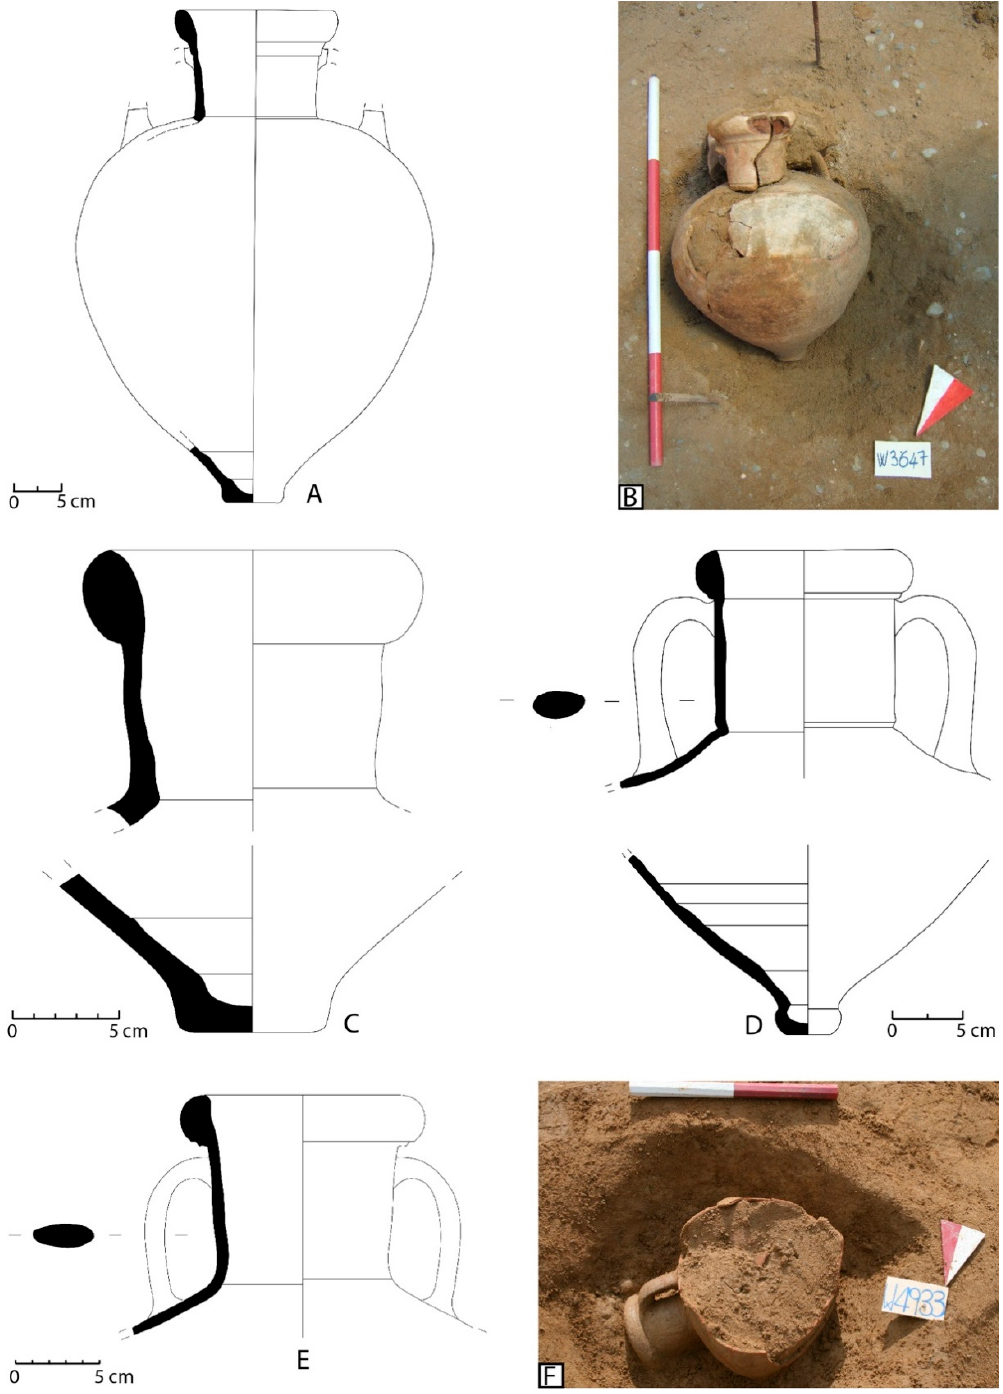
Figure 3. Amphora production of Himera, Randform 1 ( A , B ) W3647/M 179/166; Randform 2 ( C ) RO1352/M 179/150; Randform 3, variant A ( D ) W198/M 179/157 ( E , F ) W4933/M 179/162.